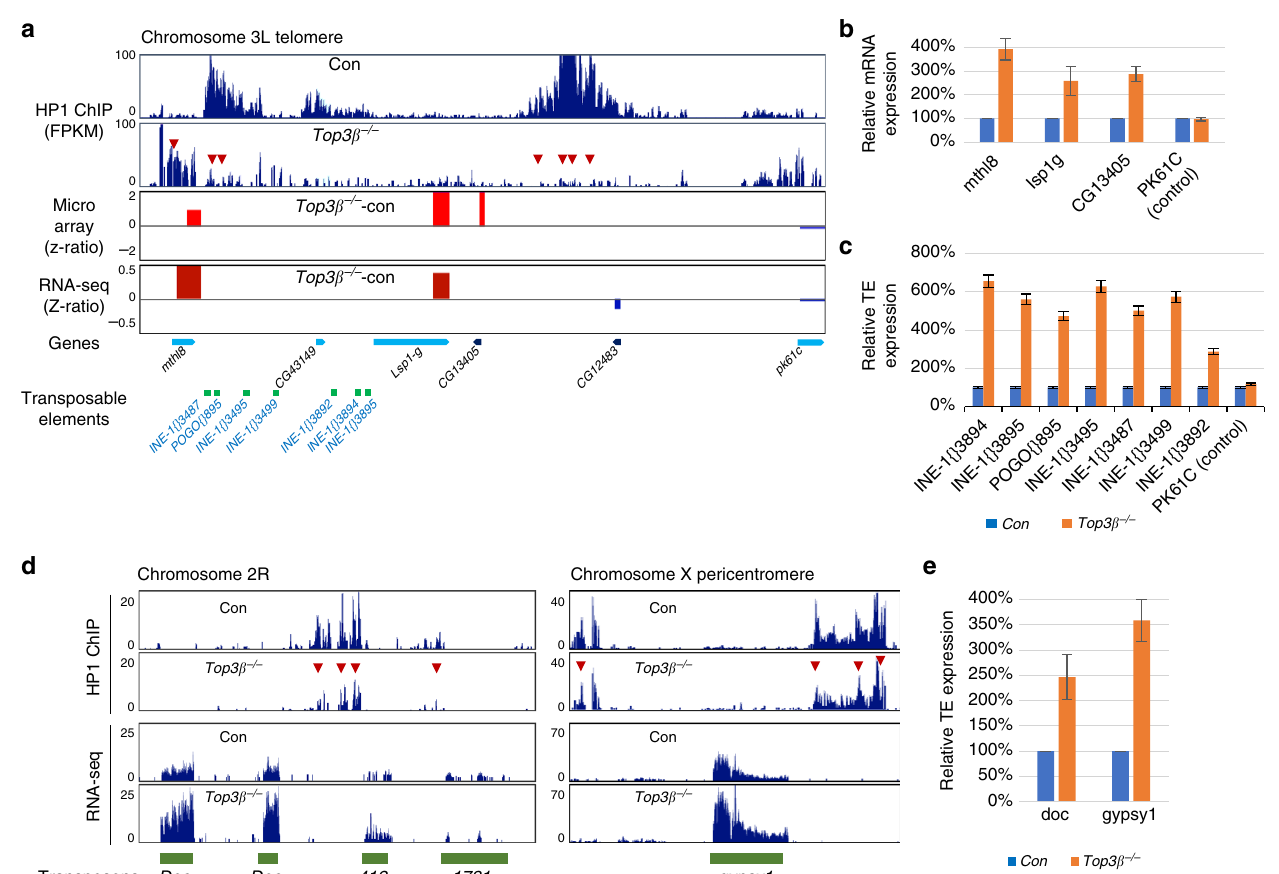
Fig. 7 Top3 β is required for heterochromatin formation and gene silencing at telomeres. a Bedgraphs of ChIP-seq, RNA-seq, and cDNA microarray data show reduced HP1 signals and increased gene expression in the telomeric region of chromosome 3L. Arrows in the ChIP-seq bedgraph indicate the regions with reduced HP1 signals in Top3 β mutant when compared to the control ( w 1118 ). The bedgraphs of RNA-seq and cDNA microarray used z -ratios ( y -axis) to show the difference in transcript levels between the Top3 β mutant and the control for several neighboring genes in this region. The increased and decreased RNA signals in Top3 β mutant are marked by red (increase) and blue (decrease), respectively. The chromosome location of genes and TEs are indicated at the bottom graph. b , c Graphs of RT-qPCR data show de-silencing of the genes ( b ) and TEs ( c ) in chromosome 3L telomere as listed in a . A negative control gene ( pk61c ) was included, which is located outside of the HP1-decreased region. d Bedgraphs of ChIP-seq and RNA-seq data show reduced HP1 signals and increased the levels of TEs in chromosome 2R (left) and chromosome X (right) pericentric heterochromatin regions. The red arrows indicate decreased HP1 ChIP signals in the Top3 β mutant. e Graphs of RT-qPCR data show de-silencing of TEs expression. RT-qPCR was performed in triplicates and TE levels were measured by normalizing with rp49 . The error bars are obtained by standard error